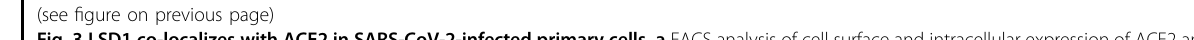
total Caco-2 population and each cell subset frequency of the total CD8 + T cells. b Representative image of PBMCs derived from COVID-19